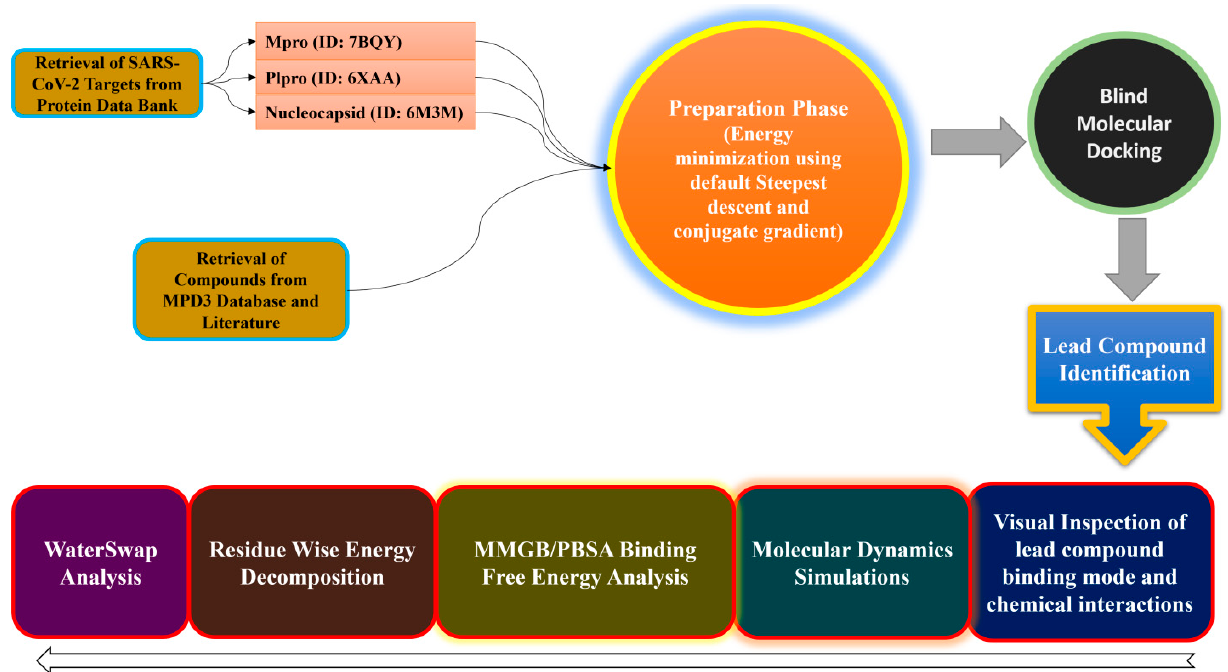
Figure 1. Schematic presentation of the methodology used in this current study.